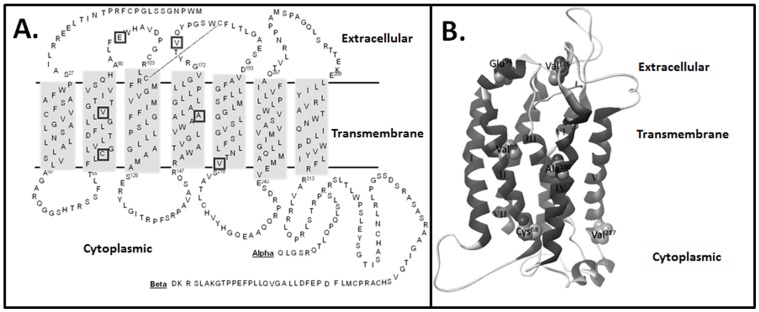
Structural Location of hTP Variants.
A. A two-dimensional secondary structure representation of the hTP indicating the position of the six non-synonymous (squares) genetic variants studied; in the extracellular region (E94V and V176E), in the upper transmembrane region (V80E and A160T), and at the cytoplasmic interface of the lower transmembrane region (C68S and V217I). B. Three dimensional homology modeling of the hTP receptor demonstrates the relative positions of these intriguing variants to occur in the ligand-recognition loop (E94V), in proximity to the structurally critical disulfide bond (V176E), lining the putative ligand binding pocket (V80E and A160T), and in proximity to the G-protein coupling site (C68S and V217I). These variants were evaluated in detail by molecular biological, biochemical, and pharmacological techniques.